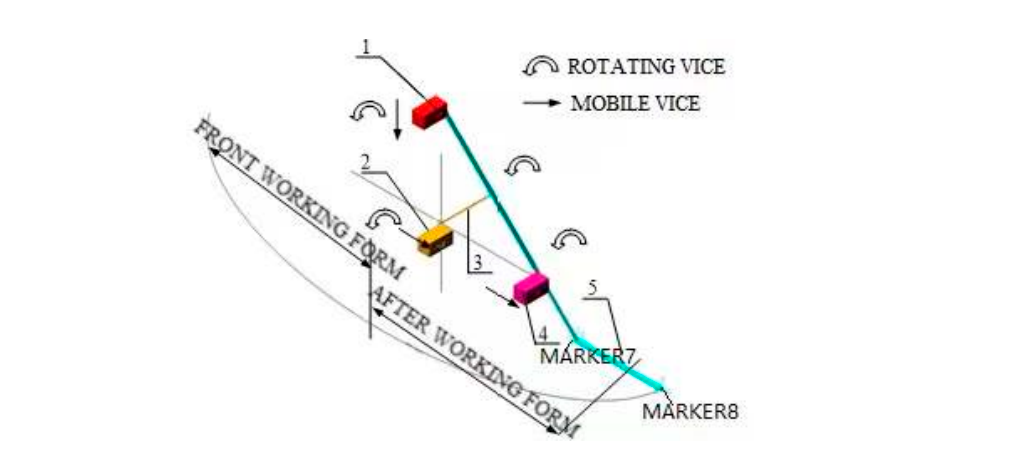
( c ) Figure 12. ( a ) The curve of combined displacement. ( b ) The curve of the horizontal displacement of the marked point with time. ( c ) The curve of the vertical displacement of the marked point with time.